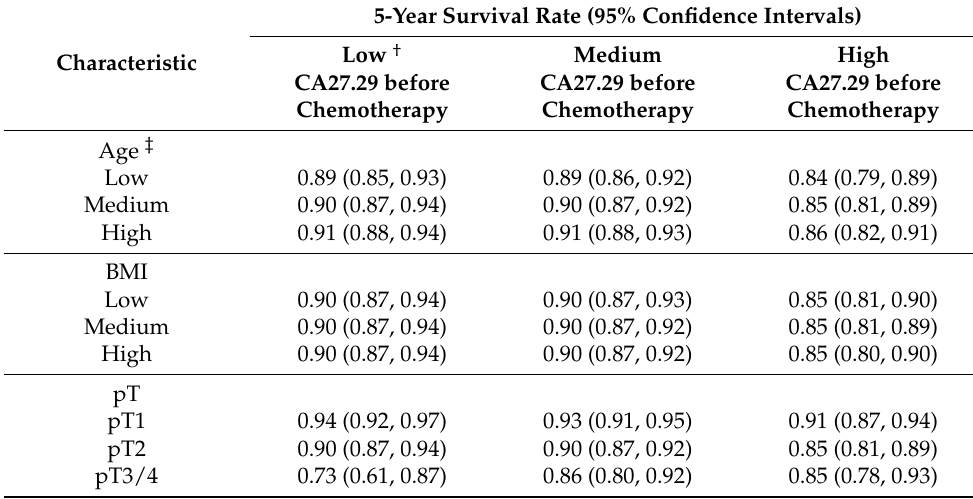
Table 3. Predicted 5-Year Disease-Free Survival Rates Relative to Patient Subgroups